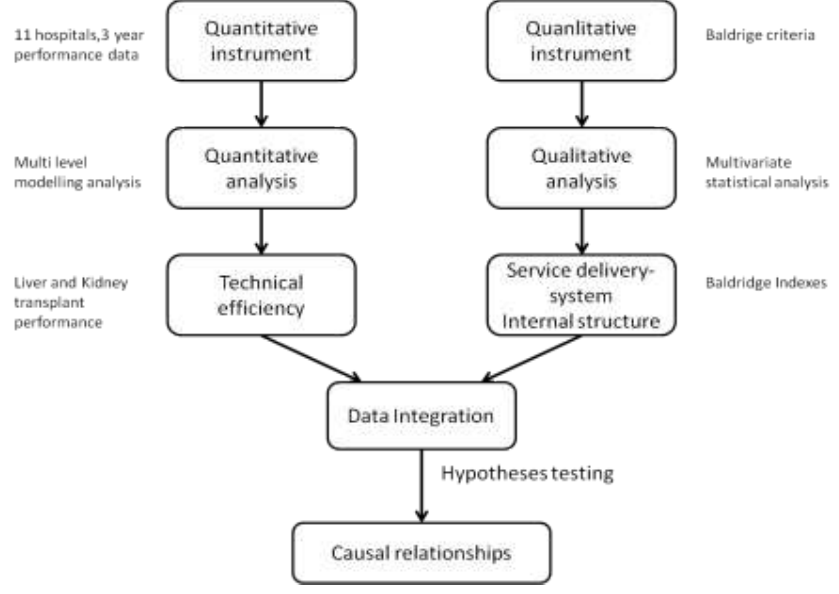
Figure 2. The research